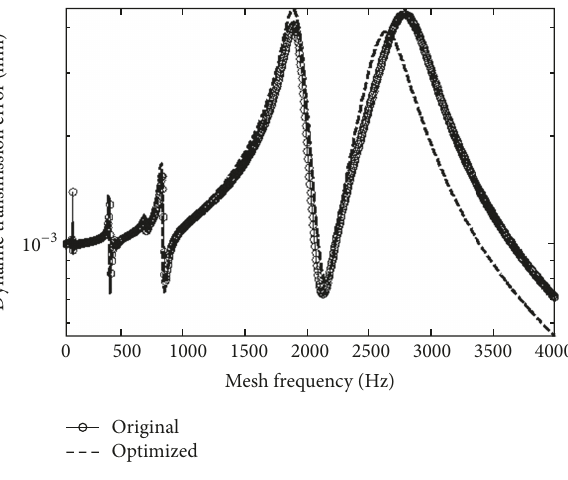
Figure 4: Dynamic transmission